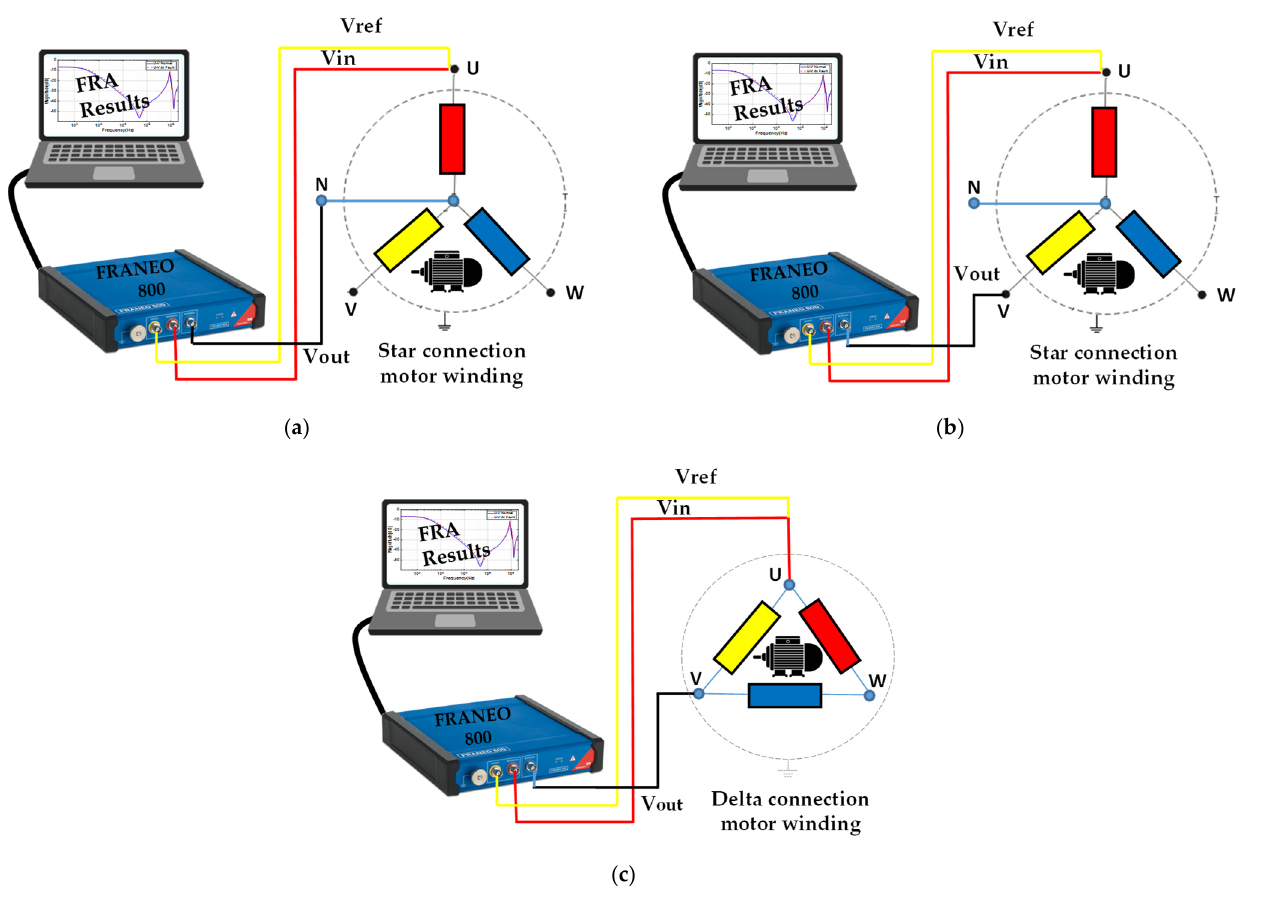
Figure 7. Schematic connection diagram for IM FRA measurement ( a ) U–N phase-to-neutral for star winding connection ( b ) U–V phase-to-phase for star winding connection ( c ) U–V phase for delta winding connection.